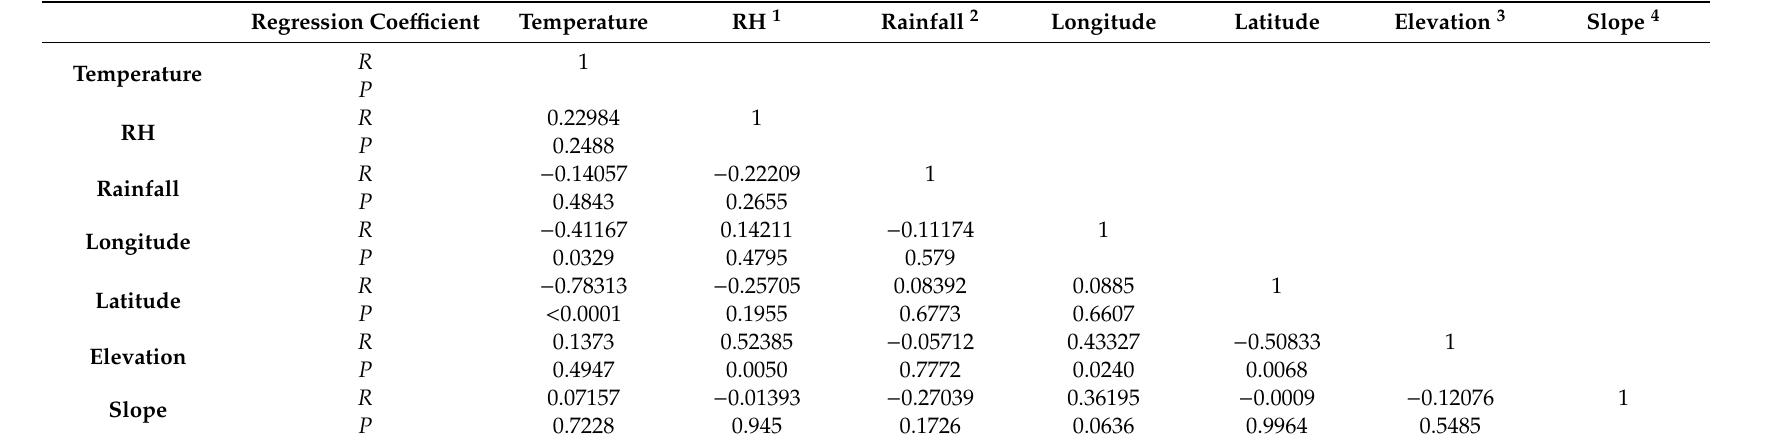
Table 3. Pearson correlation between parameters about climate and